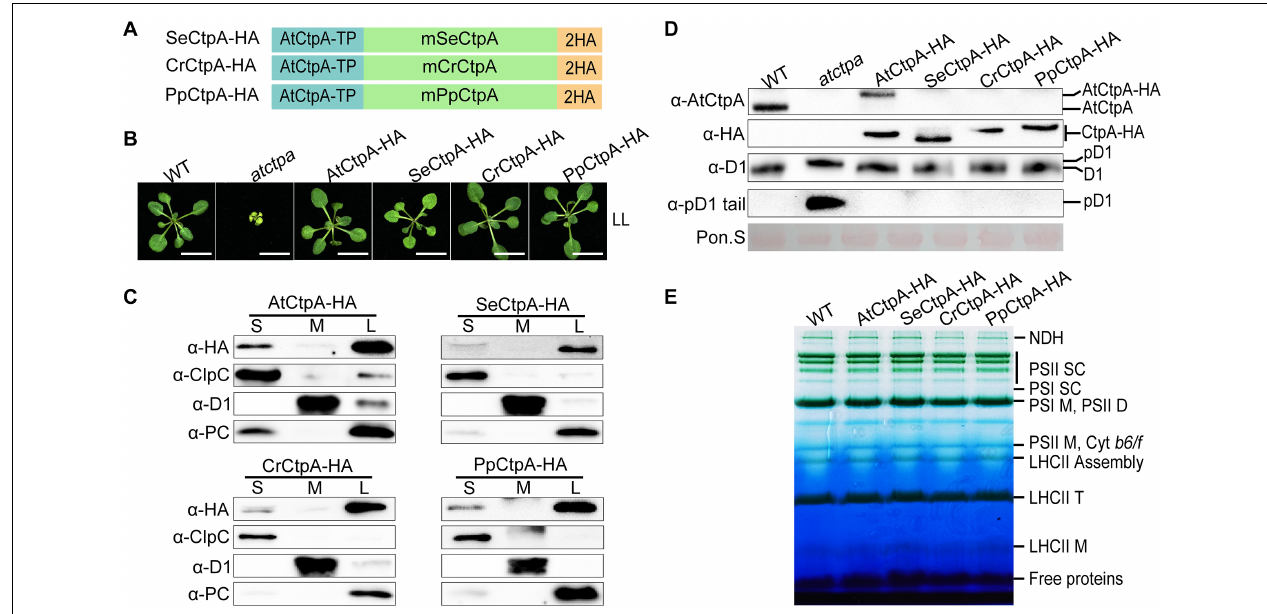
FIGURE 3 | Ectopic expression of CtpA from lower photosynthetic organisms in the atctpa mutant. (A) Schematic diagrams of fusion proteins SeCtpA-HA (from Synechococcus elongatus ), CrCtpA-HA (from Chlamydomonas reinhardtii ), and PpCtpA-HA (from Physcomitrella patens ). AtCtpA-TP is the chloroplast TP of AtCtpA protein; mPpCtpA, mCrCtpA, and mSeCtpA are the mature proteins; 2HA indicates a double hemagglutinin tag. (B) Phenotype of atctpa plants transformed with CaMV 35S promoter-driven SeCtpA-HA , CrCtpA-HA , and PpCtpA-HA . Plants were grown on 1/2 MS medium with 1% sucrose under continuous LL light (25 µ mol/s/m 2 ) for 3 weeks. At least five transgenic lines per construct were examined. Scale bars represent 1 cm. (C) Chloroplast sub-compartment distribution of AtCtpA, SeCtpA, CrCtpA, and PpCtpA. Intact chloroplasts from transgenic plants expressing AtCtpA-HA , SeCtpA-HA , CrCtpA-HA , and PpCtpA-HA were fractionated into stroma (S), thylakoid membrane (M), and thylakoid lumen (L). The distribution of CtpA in the three fractions was examined by immunoblotting with a-HA and compared with the thylakoid lumen protein PC, the thylakoid membrane protein D1, and the stromal protein ClpC. (D) D1 processing status in atctpa plants transformed with CaMV 35S promoter-driven SeCtpA-HA , CrCtpA-HA , and PpCtpA-HA . D1 processing in plants in panel (B) was analyzed by immunoblotting using the following antibodies: α -AtCtpA for AtCtpA, α -HA for ectopically expressed CtpA-HA , α -D1 for D1 and pD1, and α -pD1 tail for pD1. The filters stained with Ponceau S (Pon. S) were used as loading control. (E) BN-PAGE analyses of atctpa plants transformed with CaMV 35S promoter-driven SeCtpA-HA , CrCtpA-HA , and PpCtpA-HA . The transgenic and WT plants were grown in soil under continuous NL light (80 µ mol/s/m 2 ) for 3 weeks before analyses. Thylakoid membrane protein complexes (12 µ g chlorophyll) were loaded on a BN-PAGE gel for